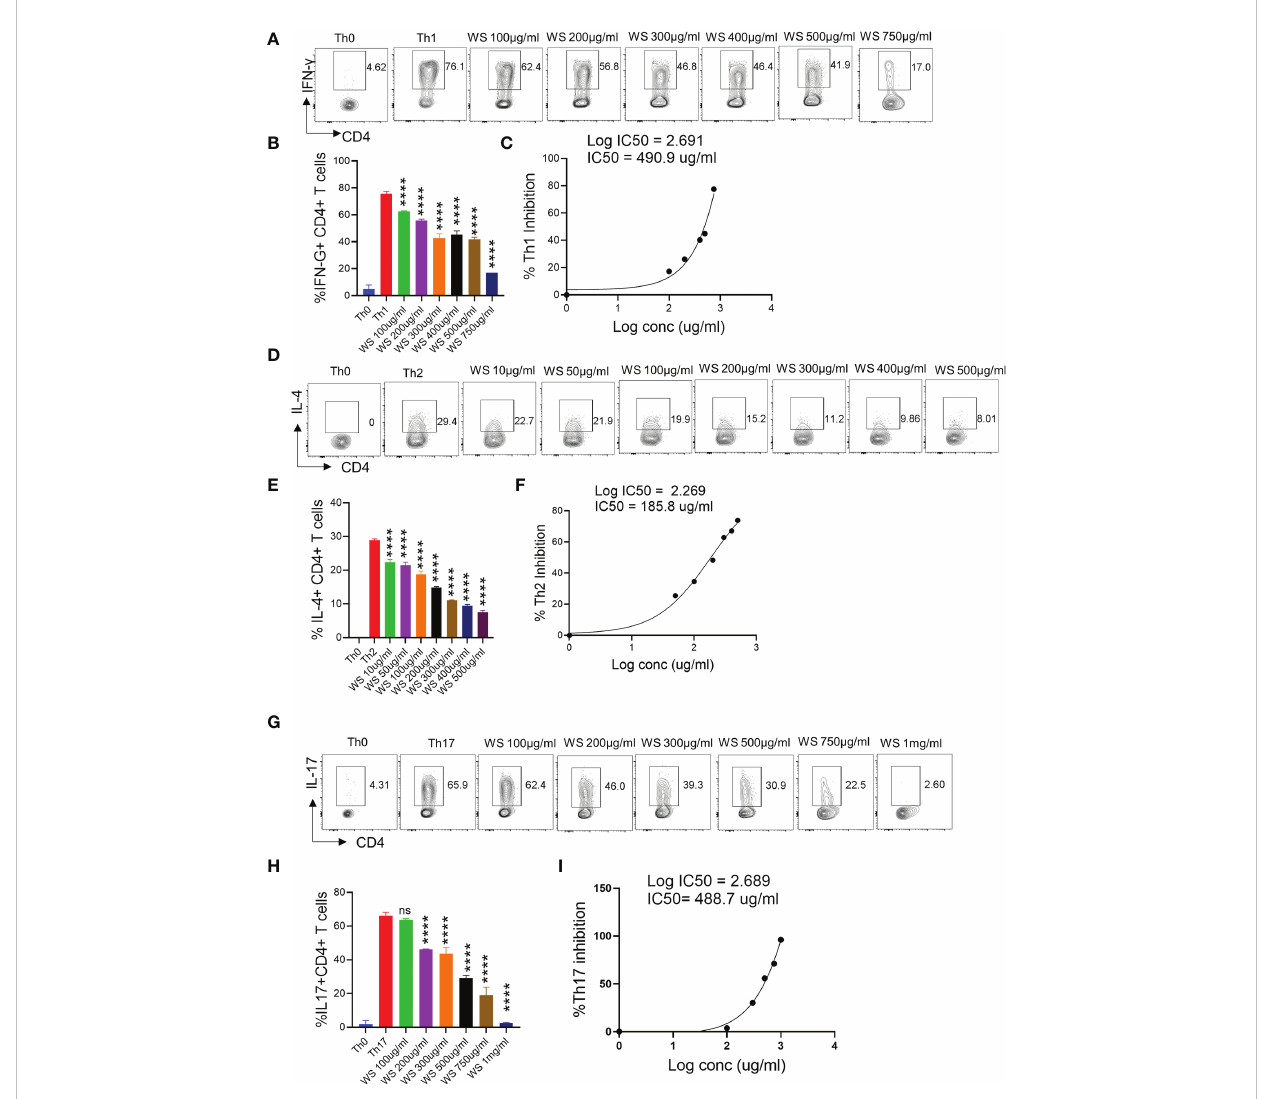
FIGURE 5 Dose kinetics of WS response on in vitro differentiation of Th1, Th2 and Th17 cells from naïve CD4+ T cells. Sorted naïve CD4+ T cells from mouse spleen and lymph nodes were activated using soluble anti-CD3 antibody and differentiated into helper T (Th)2 (A, B) , Th17 cells (D, E) and Th1 subtypes (G, H) by using different cytokines viz recombinant mouse IL-4; TGF- b + IL-6 and IL-12 cytokines respectively. WS was added in concentrations ranging from 10ug/ml to 1000ug/ml initially at the time of cell seeding. After 72 h of incubation IL-4, Il-17 and IFN-gamma production was measured respectively for Th2, Th17 and Th1 cells by intracellular cytokine staining. IC50 values were calculated using Graph pad prism software (C, F, I) . ****P < 0.0001 by one-way